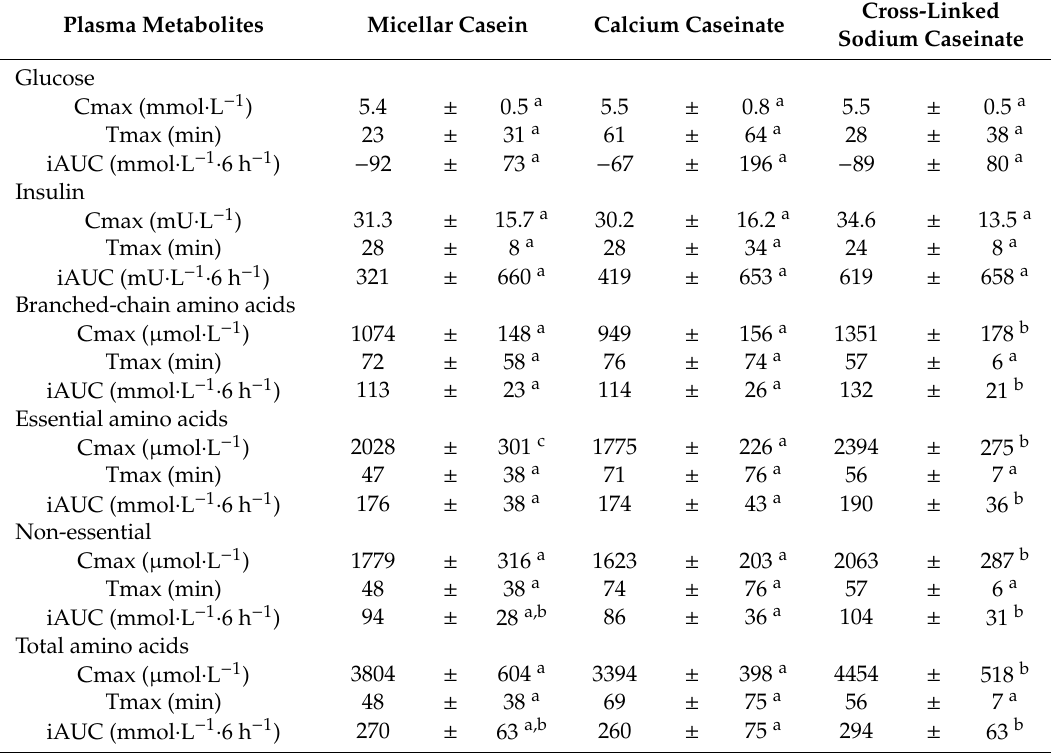
Table 1. Plasma glucose, insulin, and amino acid